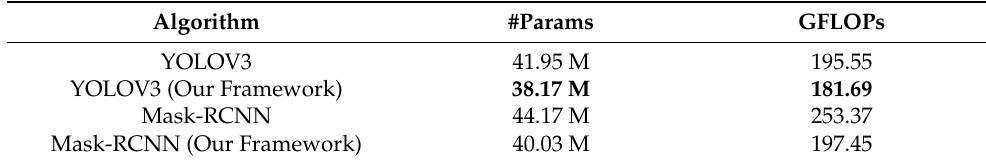
Figure 10. Some of the detection results obtained by the proposed overall framework on Mask RCNN. Table 3. The parameters and GFLOPs of the proposed method. We use input feature map of size [1 × 1800 × 800] to evaluate their complexity during inference. All the number are the smaller the